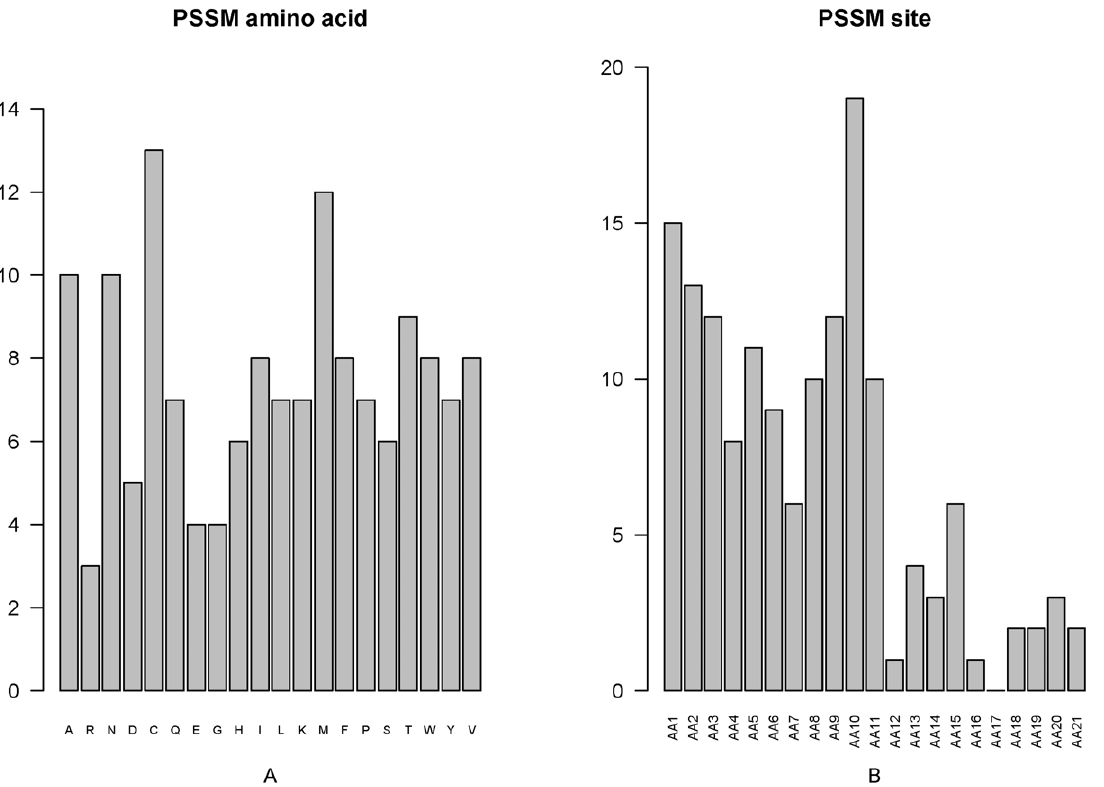
Figure 3. Feature and site specific distribution of the PSSM features in the optimal feature set. (A) Feature distribution of the PSSM features in the optimal feature set. The conservation against mutations to amino acid C, M A, N and T influent more on PCA modification determination than the mutations to other amino acids. (B) Site-specific distribution of the PSSM features in the optimal feature set. The conservation status of ‘‘AA10’’, ‘‘AA1’’ and ‘‘AA2’’ sites were most important for the PCA modification site prediction.